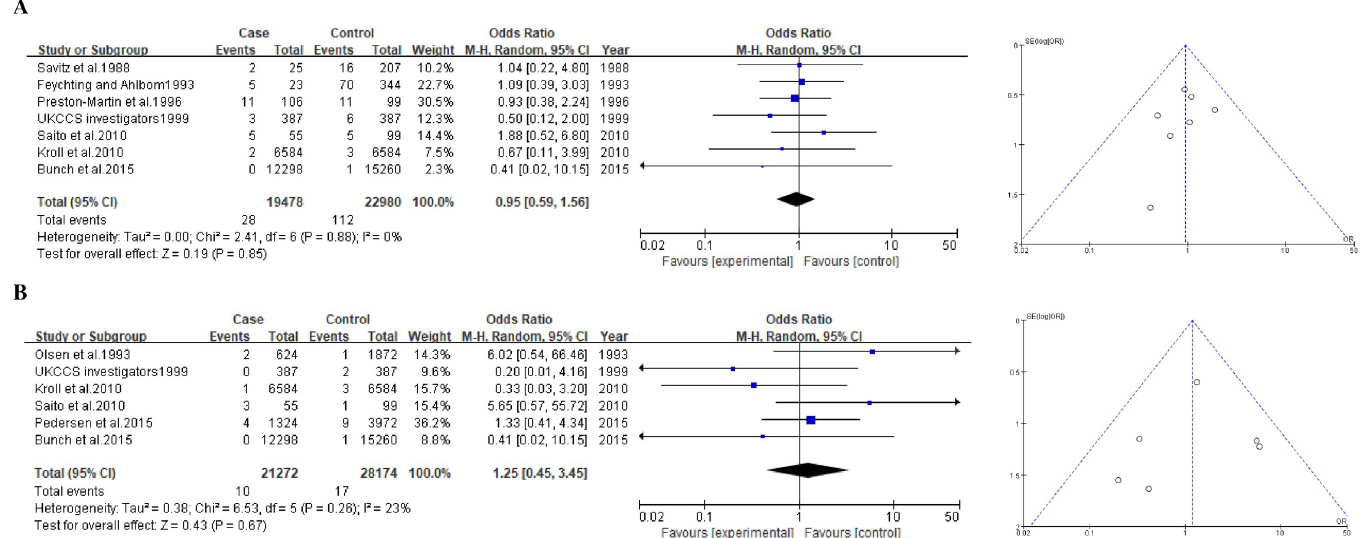
Fig 3. Forest plot and funnel plot of exposure to ELF-MFs and risk of childhood brain tumor. The pooled odds ratio of childhood brain tumor by each exposure level of ELF-MFs: A 0.2- μ T exposure level; B 0.4- μ T exposure level.